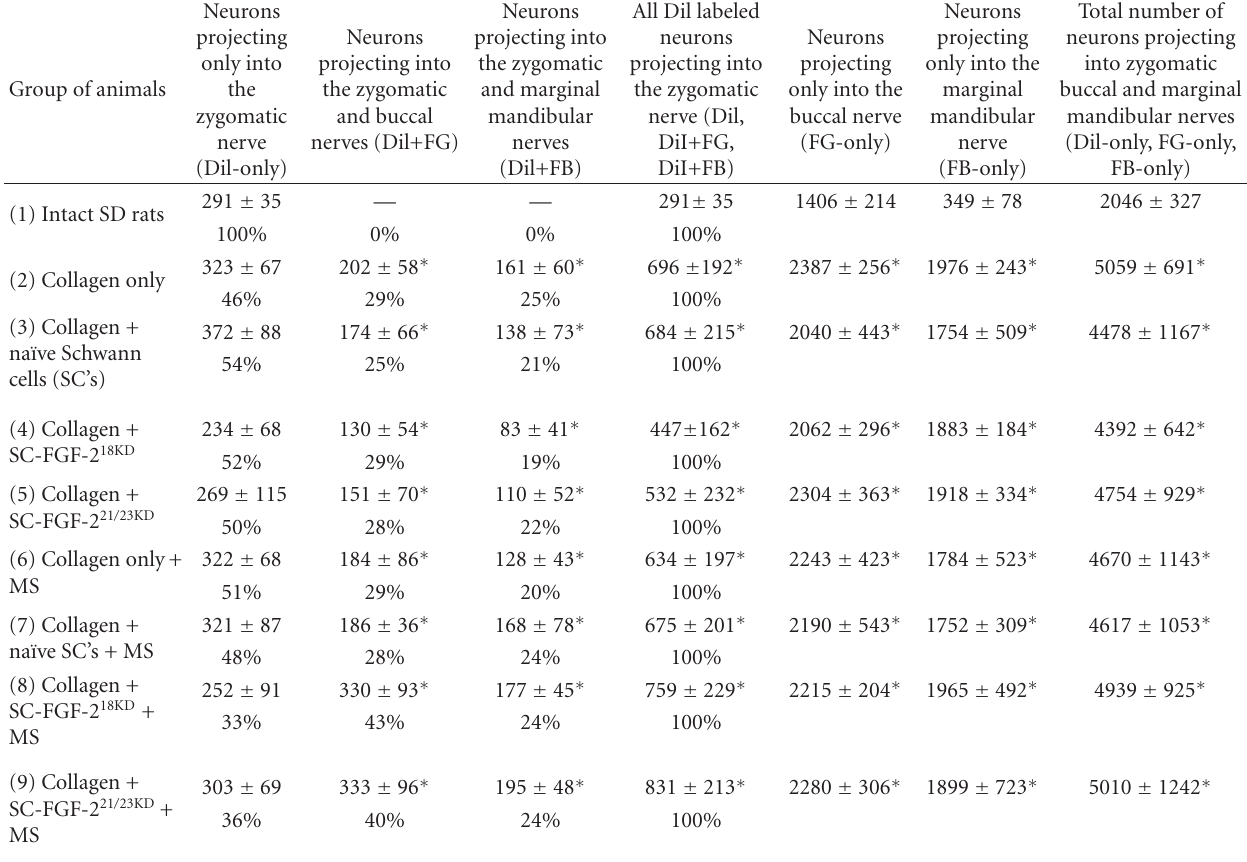
Table 2: Projection patterns of facial motoneurons. Number of motoneurons with axons in the zygomatic, buccal, or marginal mandibular branches of the facial nerve of intact rats (Group 1: Intact), in rats after transection of the right facial nerve followed by entubulation with collagen only (Group 2: Collagen), with collagen plus naive SC’s (Group 3: Collagen+SC’s), or with collagen plus genetically modified SC’s (groups 4 and 5). In groups 6–9 entubulations were followed by manual mechanical stimulation (MS) of the vibrissal muscles.